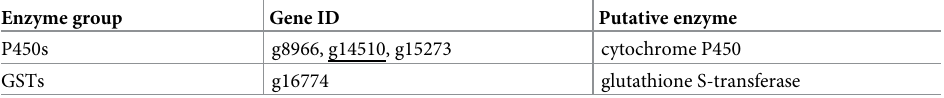
Table 5. Candidate genes putatively involved in detoxification identified in the transcriptome of A . compressa adult wasps. Enzyme group Gene ID Putative enzyme P450s g8966, g14510, g15273 cytochrome P450 GSTs g16774 glutathione S-transferase Given are up- and down-regulated differentially expressed genes (DEGs) with a putative function in detoxification. Underlined gene IDs were found as down- and non-underlined gene IDs as up-regulated DEGs. Detailed information can be found in the S5 Table.